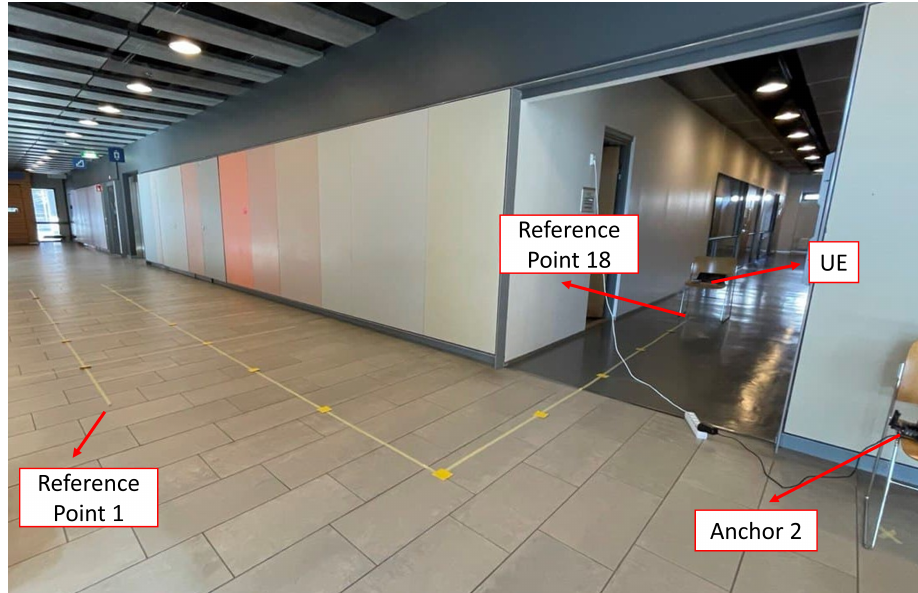
Figure 9. Reference points for evaluating the results inside the hall and the corridor.